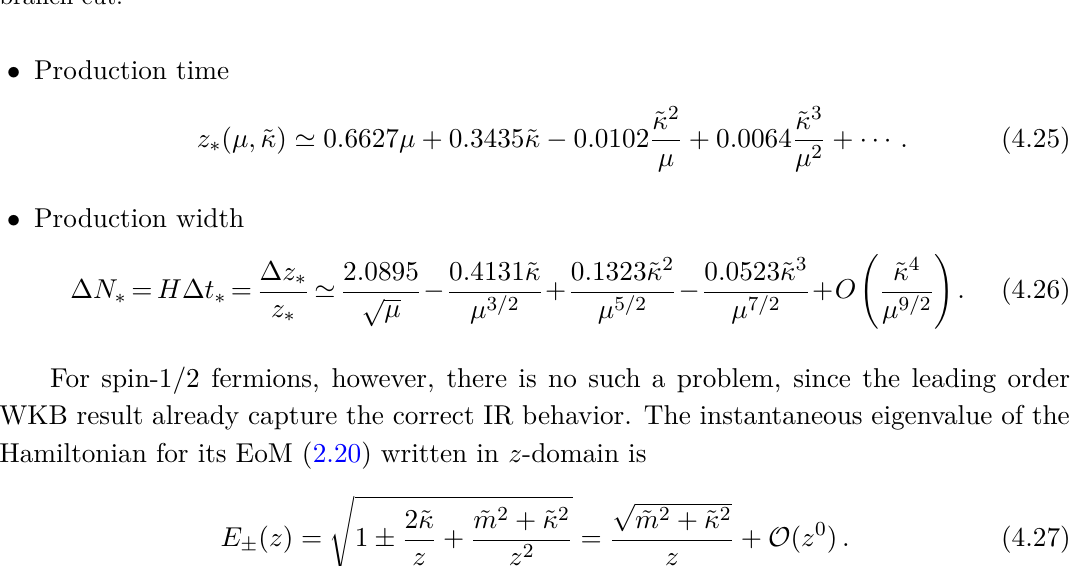
Figure 7 . The integration contour can be deformed from along the Stokes line ( C 0 ) to along the branch cut ( C 1 ∪ C 2 ), collecting half of the residue at z = 0 + . The black dashed line indicates the branch